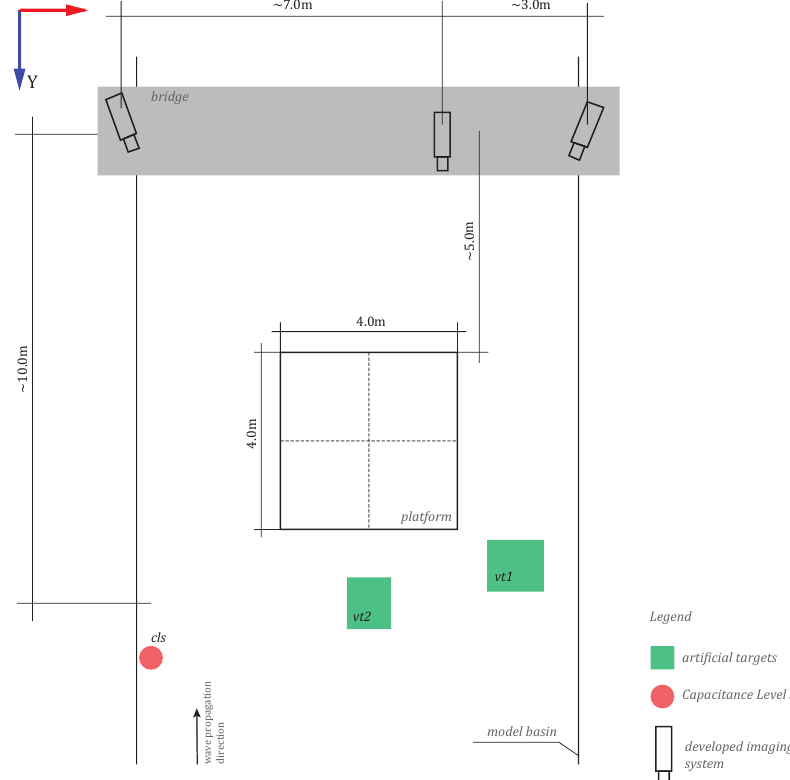
Figure 11. The top view of the measurement workplace. Cameras on top of the drawing are placed on a mobile bridge. The platform occupies the scene’s central part and is located ca . 5 m away from the bridge. The green rectilinear shapes correspond to the zones of the artificial targets (used in Method 1, and in the evaluation of Methods 1 and 2; see Section 3.1 and Section 5), while the red circle is the capacitive level sensor (used in the evaluation of Methods 1 and 2; see Section 5).